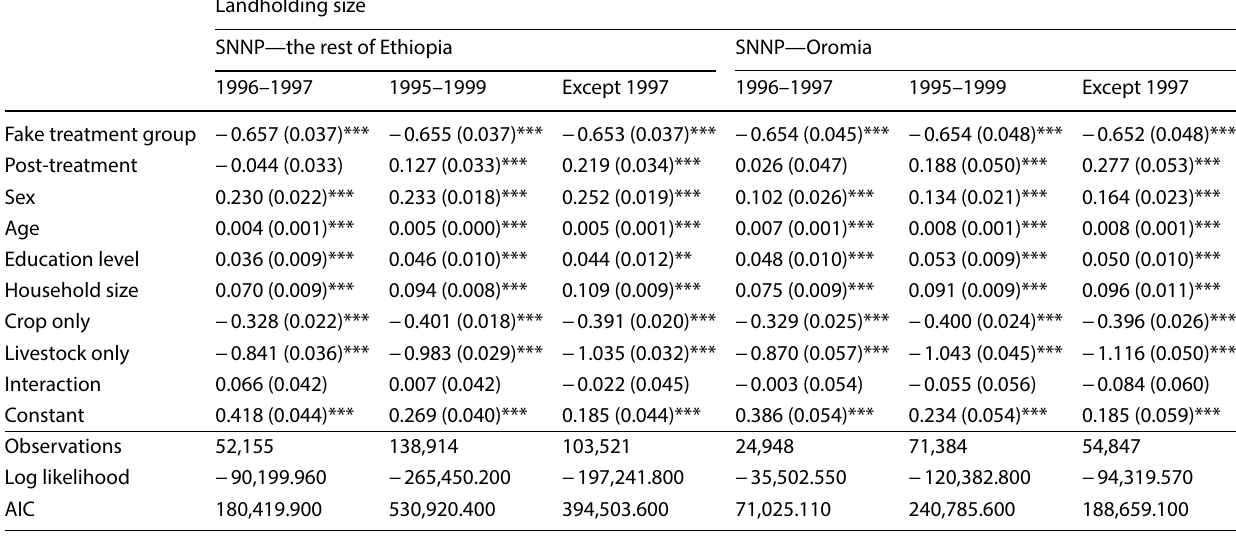
Table 6 Parallel trend assumption check using the fake treatment group